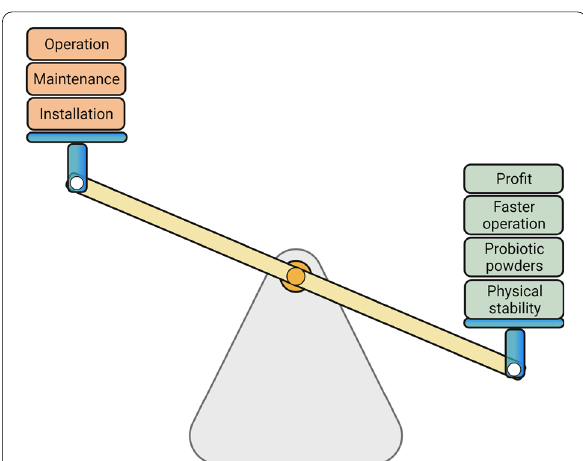
Fig. 2 Cost analysis and benefits of microencapsulation